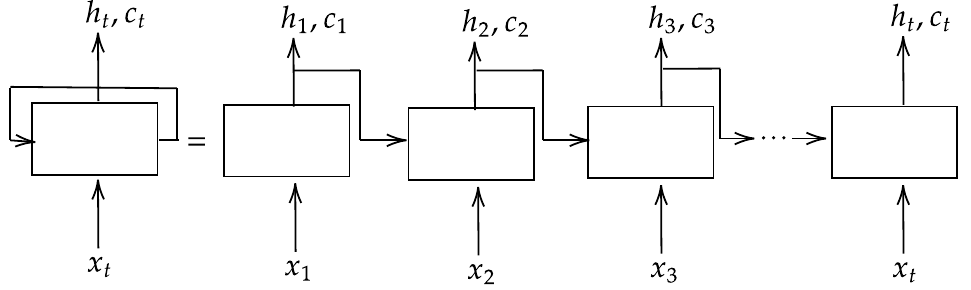
Figure 3. LSTM in loops and unfolded in